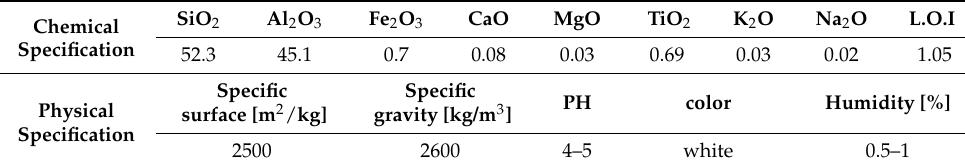
Table 3. Physical and chemical specification of MK.